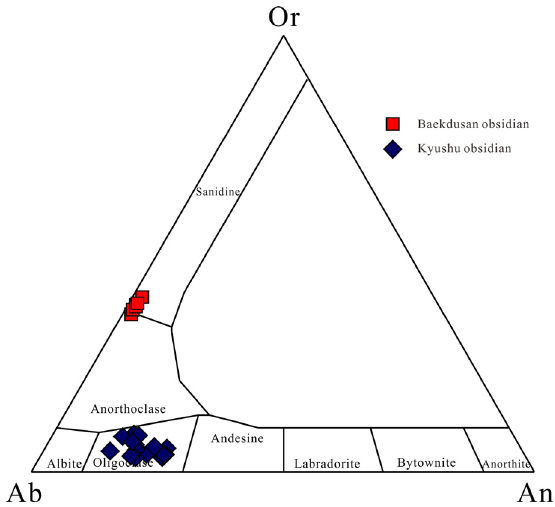
(En)-FeSiO (Fs) discrimination of clinopyroxene. 3 3